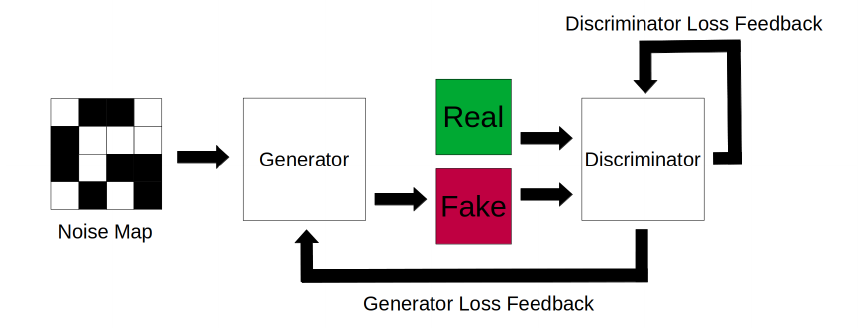
Figure 7. Basic model of a classical GAN training